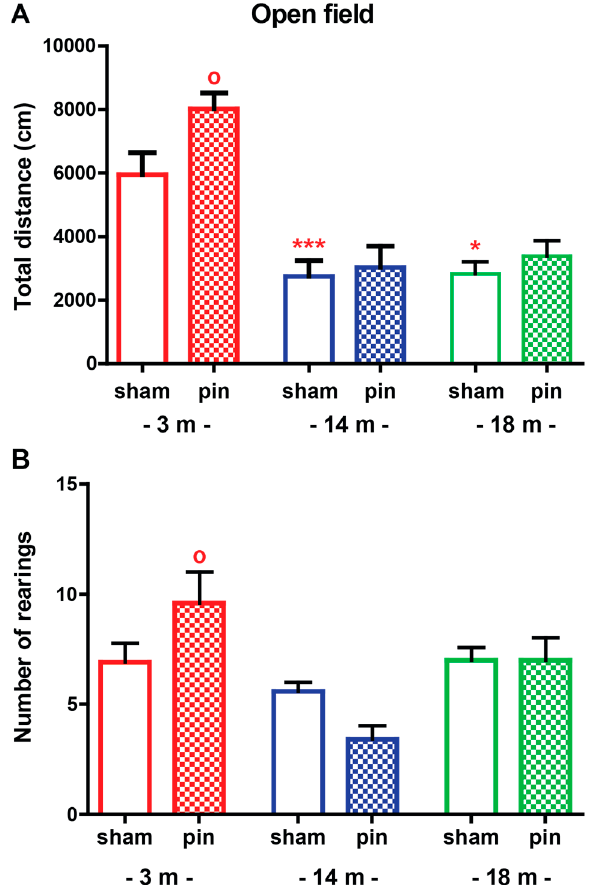
Figure 1. The effect of pinealectomy (pin) on total distance travelled (cm) ( A ) and number of rearing events ( B ) of 3, 14 and 18-month-old rats tested in the open field test. Data are presented as mean ± S.E.M. *** p < 0.001, 14-month-old sham compared to matched 3-month-old group; * p = 0.016, 18-month-old rats sham compared to matched 3-month-old group; o p = 0.029, 3-month-old pin compared to matched sham group ( A ); o p = 0.029, 3-month-old pin compared to matched sham group ( B ). 3-month-old rats—red; 14-month-old rats—blue; 18-month-old rats—green.